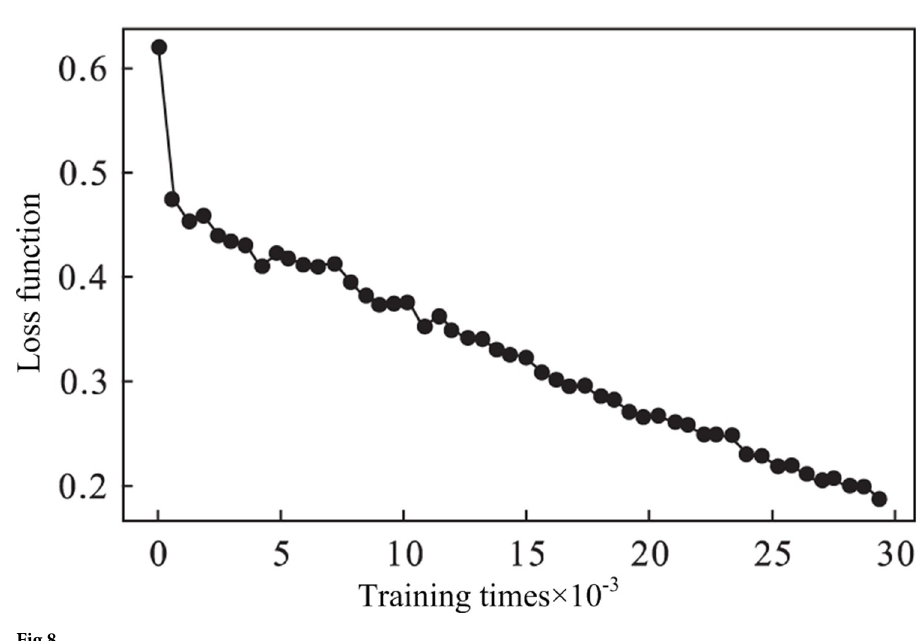
Fig 8. https://doi.org/10.1371/journal.pone.0235672.g008 set. The horizontal ordinate shows the number of training times with all samples, and the ordi- nate shows the error rate and accuracy rate. From the results in the Figure, it can be concluded